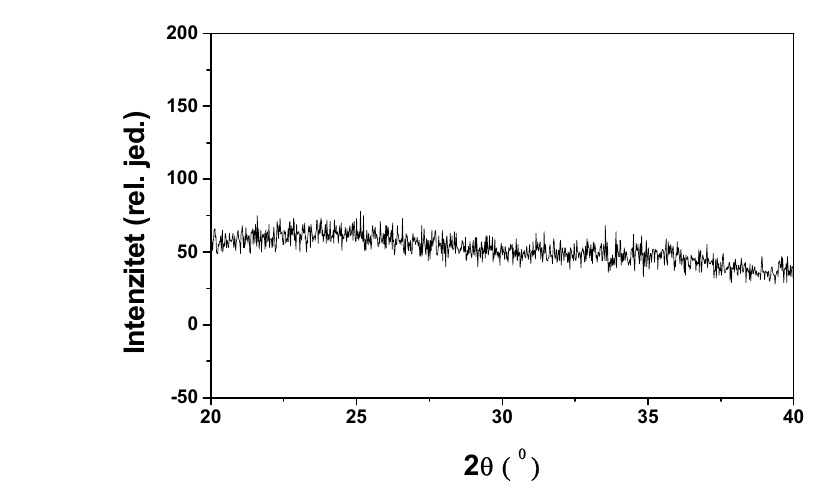
Figure 2 – X-ray powder diffraction pattern of the nanocomposite α -Fe 2 O 3 /SiO